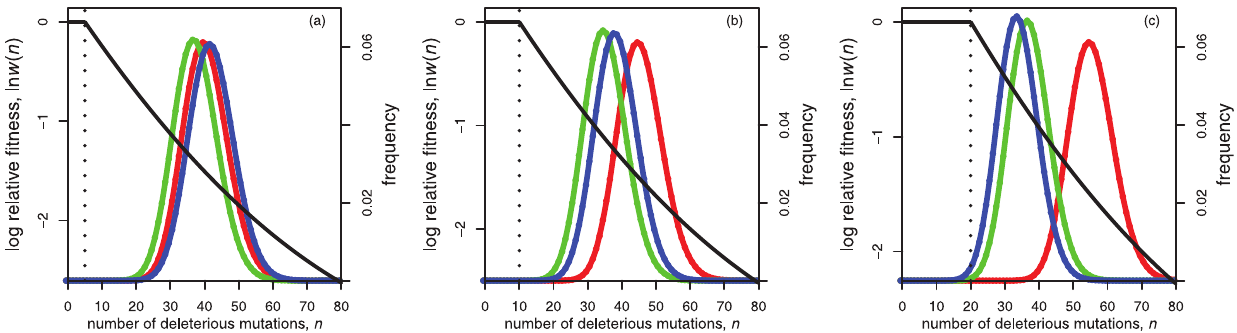
Figure 5. Fitness landscapes and equilibrium frequency distributions. The landscapes shown are identical to that shown in Figure 1c ( a 2 ~ 0 : 050 , b ~{ 0 : 0004 ) with the exception of an initial neutral ridge (i.e., the first k mutations accumulated cause no appreciable loss in fitness). Parameter values are: (a) U ~ 0 : 5 , k ~ 10 , (b) U ~ 1 : 5 , k ~ 10 ; (c) U ~ 1 : 5 , k ~ 20 . All curves assume an effectively infinite population, and the red (asexual) curve in panel (c) would be unlikely to apply to any population of plausible finite size. All conventions as Figure 1.